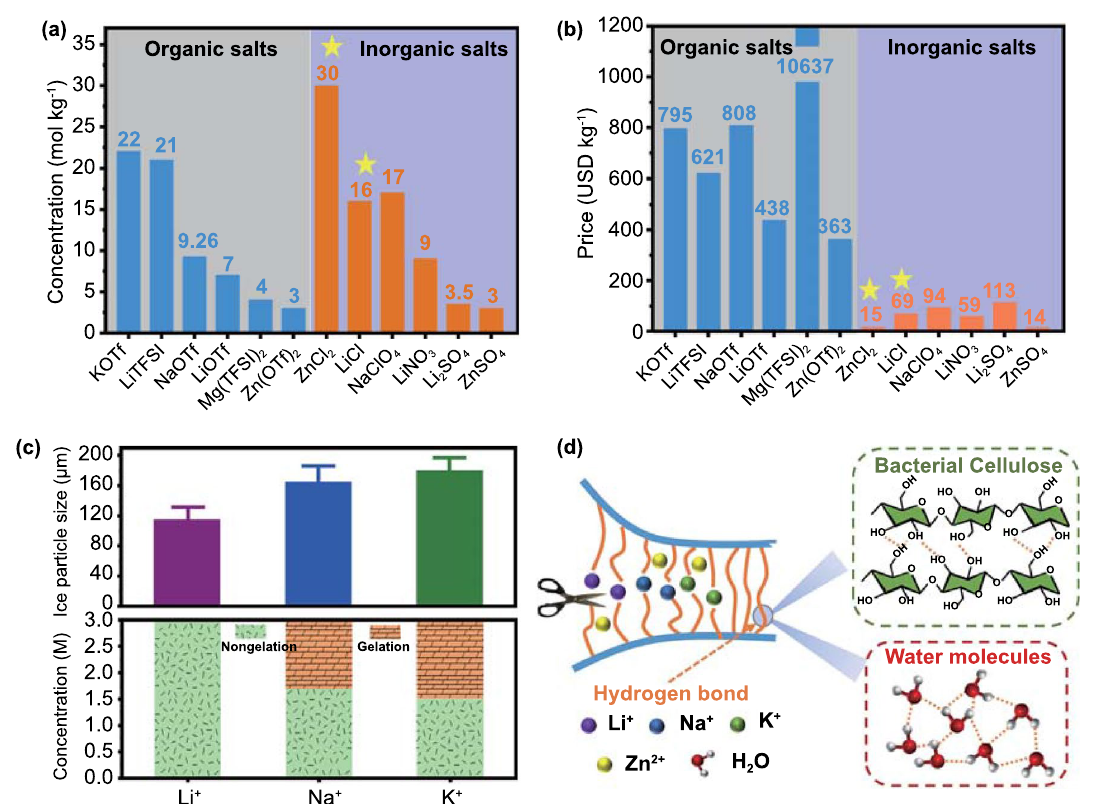
Fig. 1 Comparison of a concentration and b price between organic salts (KOTf [50], LiTFSI [16], NaOTf [51], LiOTf [52], Mg(TFSI) 2 [53], and Zn(OTf) 2 [54]) and inorganic salts (ZnCl 2 [55], LiCl [42], NaClO 4 [56], LiNO 3 [42], Li 2 SO 4 [42], and ZnSO 4 [57]). c Influence of Li + , Na + , and K + on the size of ice crystals and crystalline state (nongelation and gelation) of PVA chains (Cl − was used as the common anion) [26, 27]. d Schematic diagram of interrupted H-bonds between cellulose and cellulose chains, water and water molecules induced by cations (Li + , Na + , and K +